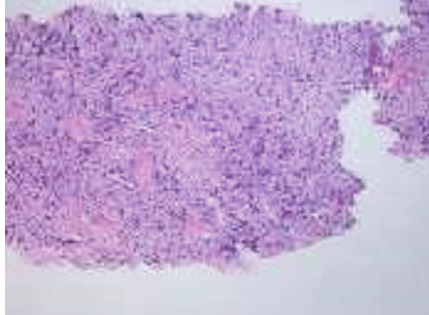
Figure 3: Hematoxylin and eosin specimen demonstrating infiltra- tive cells with high mitotic and apoptotic indices.